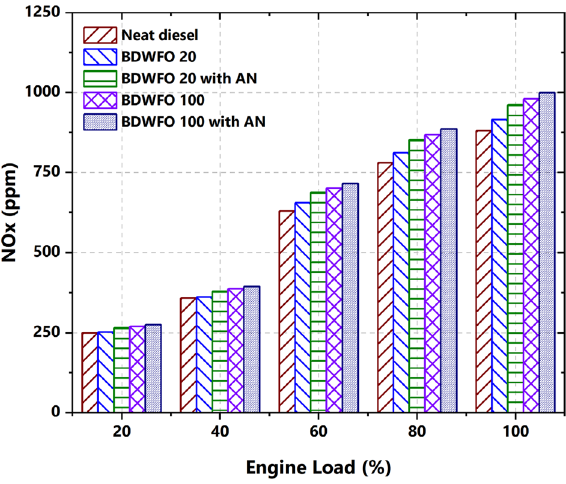
Figure 12. NOx emission—NOx versus variation on load